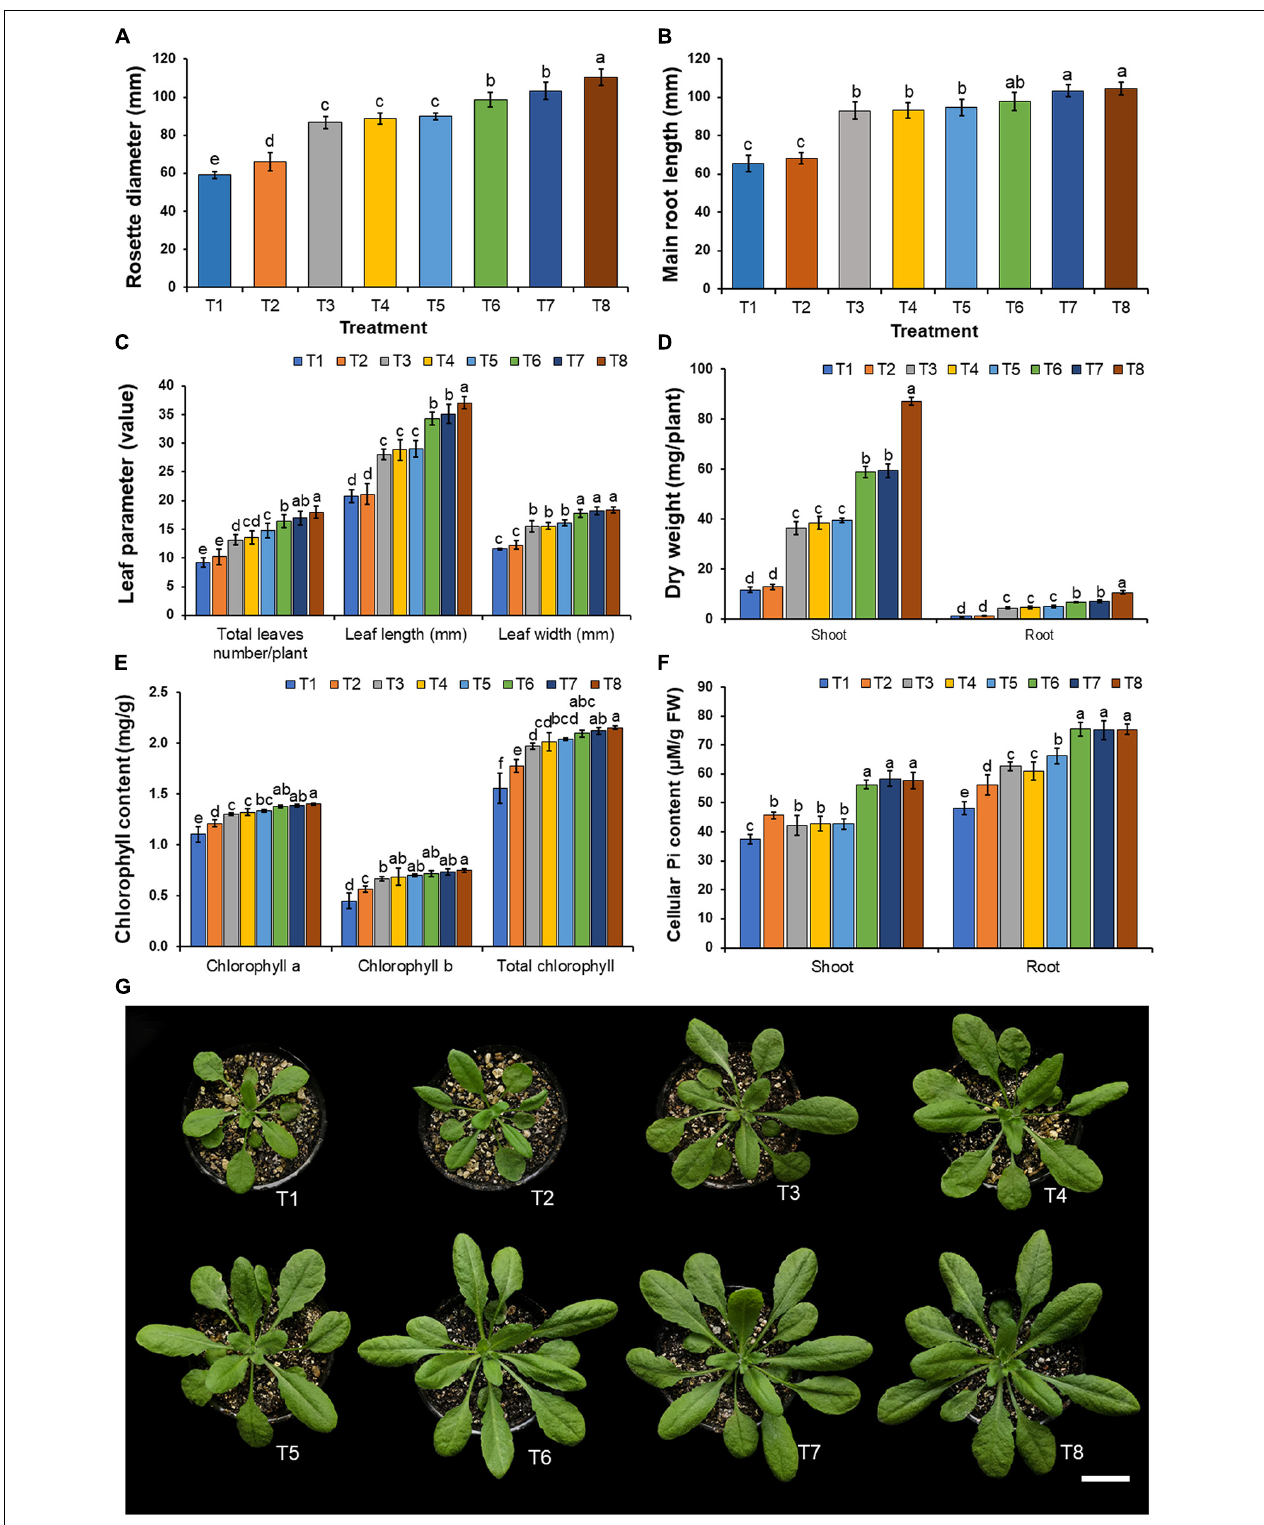
FIGURE 6 | Effect of mineral-solubilizing fungi on the growth of Arabidopsis. (A) Rosette diameter, (B) main root length, (C) total leaf number, leaf length and leaf width, (D) shoot and root dry weight, (E) chlorophyll content, (F) cellular inorganic phosphate content, (G) Arabidopsis in each treatment. Error bars represent the standard deviation of the mean. The different letters indicate significant difference ( p ≤ 0.05). Scale bar: (G) 2 cm.